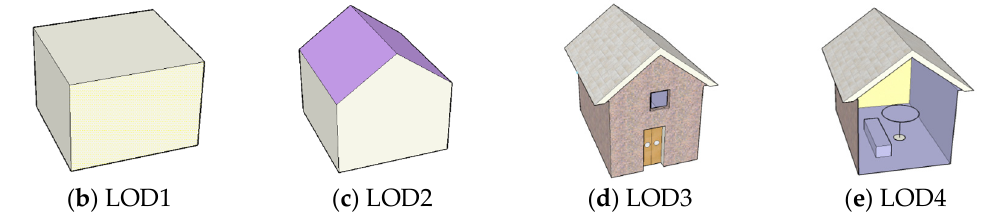
Figure 5. The five LODs of CityGML: ( a ) LOD0: 2D symbol; ( b ) LOD1: simple geometry; ( c ) LOD2: simple geometry combinations; ( d ) LOD3: geometry with realistic textures; ( e ) LOD4: real internal structure. Three-dimensional map symbols differ from the abstract characteristics of 2D map symbols. They not only reflect the essential features and general properties of a feature, but more importantly, also represent the complex surface property information of a feature.